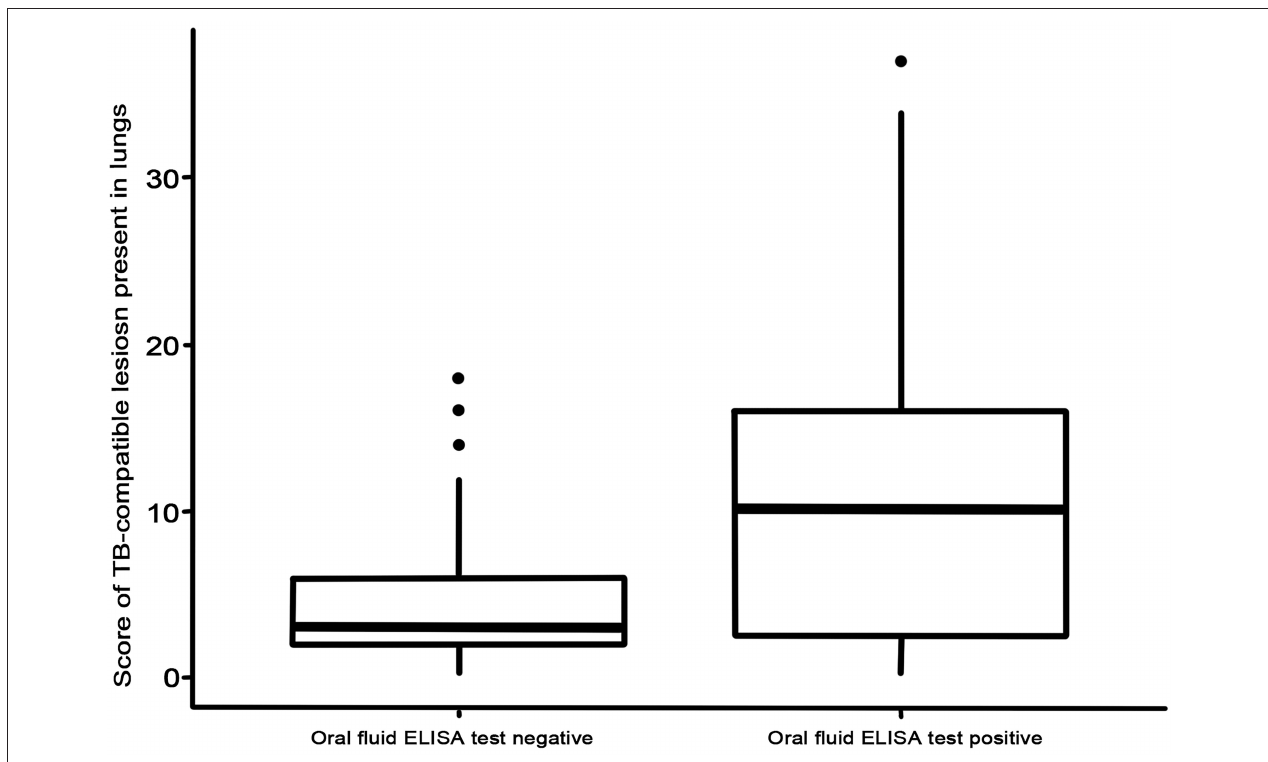
FIGURE 1 | Lung lesion score for negative and positive animals tested using P22 ELISA with oral fluid samples.